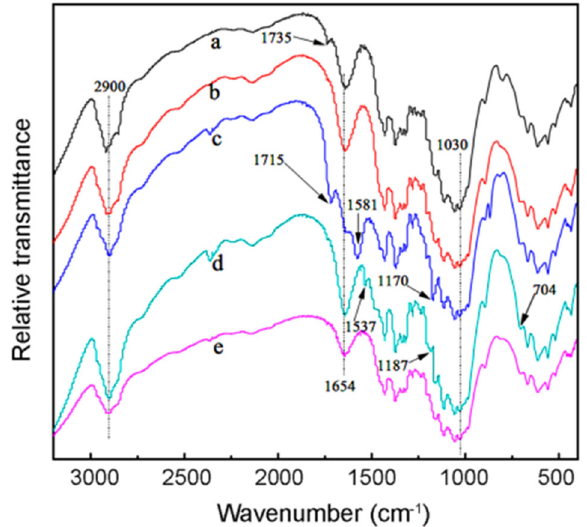
Fig. 16 FTIR spectra of (a) untreated fi ber, (b) alkali-treated fi ber, (c) MA grafted fi ber, (d) corona-treated fi ber, and (e) silane-treated fi ber 147 .